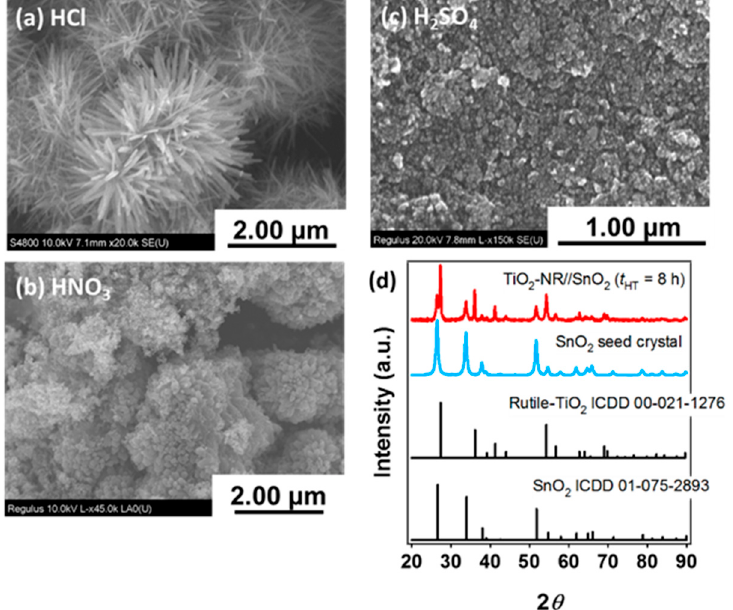
Figure 1. SEM images for the TiO 2 ‐ SnO 2 hybrids prepared by the hydrothermal method under acidic conditions using HCl ( a ), HNO 3 ( b ), and H 2 SO 4 ( c ): hydrothermal reaction time ( t HT ) = 8 h. ( d ) X-ray diffraction patterns of the samples before and after the hydrothermal method under acidic conditions using HCl. The figures are taken from Reference [15] (reproduced with permission from Akita, A.; Kobayashi, H.; Tada, H., Chem. Phys. Lett. ; published by Elsevier, 2020). Transmission electron microscopy (TEM) analyses of the particles generated at the early stage of reaction provide information about the crystal growth mechanism and the state of the junction between SnO 2 and TiO 2 . The TEM image of a particle generated at t HT = 1 h shows a single TiO 2 NR grown from a SnO 2 seed crystal with the mean lengths of short axis (~13 nm) and long axis (~90 nm) (Figure 2a). An atomically commensurate junction is also formed between the SnO 2 seed and TiO 2 NR, whose lattice spacings near the interface are close to the values of the (110) crystal planes. A plausible interface model is proposed based on the analysis of the high ‐ resolution (HR) ‐ TEM images (Figure 2b,c), where the TiO 2 -NR and SnO 2 are connected with an orientation of (001) TiO2 //(001) SnO2 , and the TiO 2 NR grows toward the [001] direction. Consequently, anisotropic one-dimensional (1D) TiO 2 ‐ NR//SnO 2 particles are formed during the initial process of reaction. Density functional theory (DFT) simulations indicated that Cl- ions act as a habit modifier in this reaction, i.e., their preferential adsorption on the oxygen ‐ defect sites on the rutile TiO 2 (110) plane induces the anisotropic growth of TiO 2 in the [001] direction yielding the NR with the {110} side walls [15].